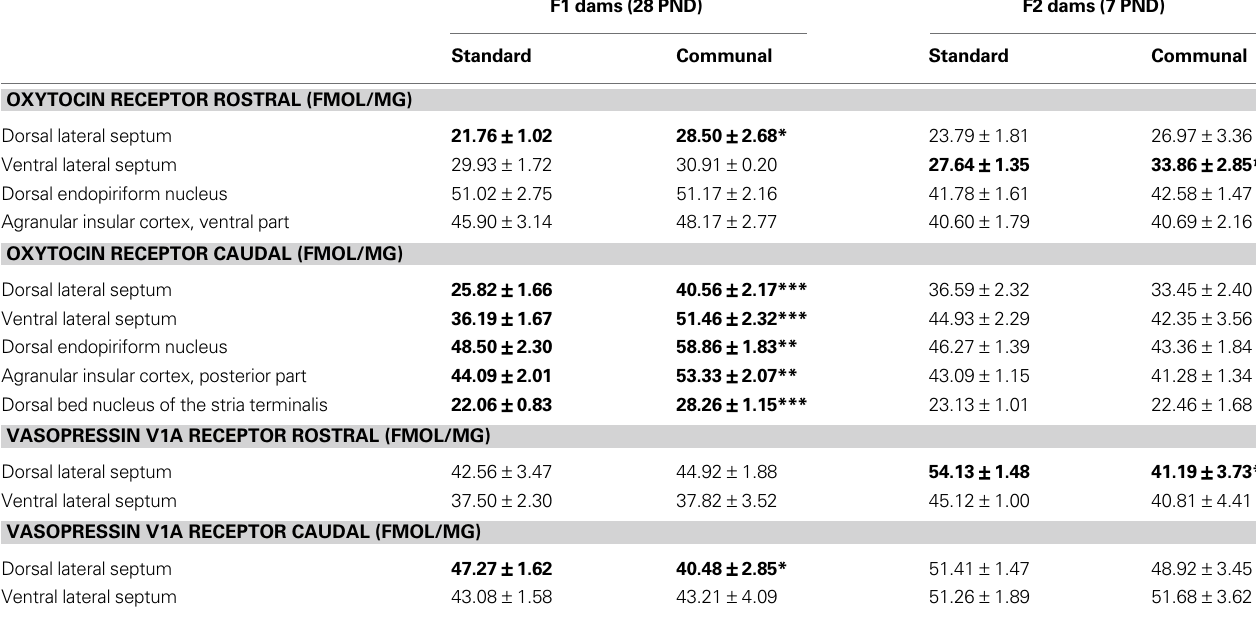
Table 5 | Oxytocin and vasopressin V1a receptor binding in F1 and F2 females. F1 dams (28 PND) F2 dams (7 PND) Standard Communal Standard